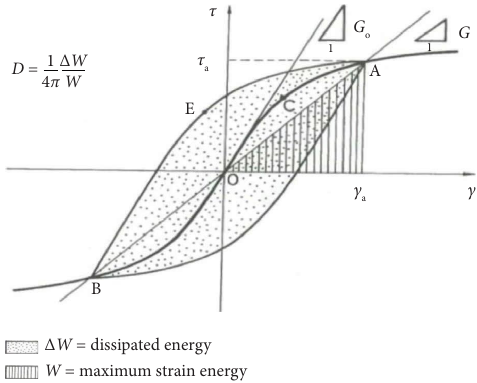
Figure 3: Hysteretic loop for one cycle of loading showing G or G , G , and D or ξ 0 max